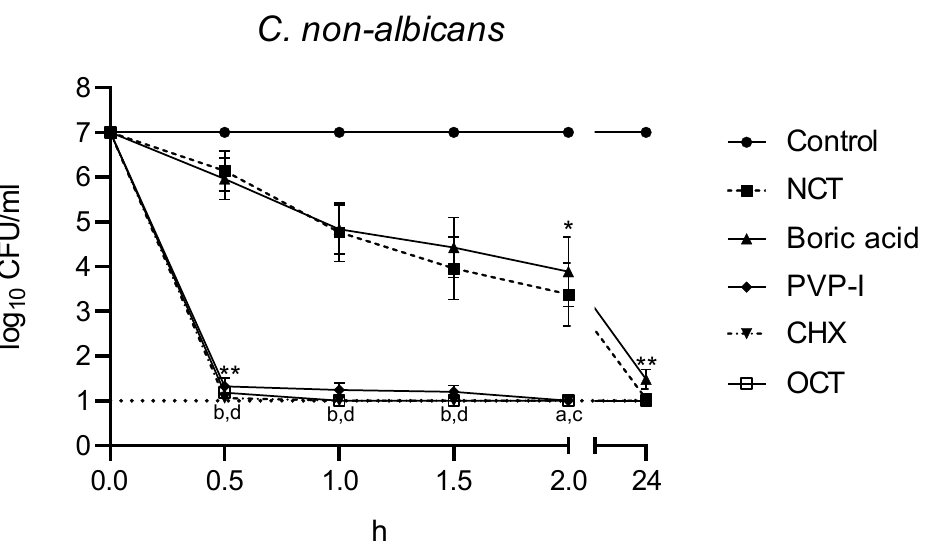
Figure 3. Fungicidal activity of antiseptics against C. albicans (n = 29) at 37 °C and pH 7. Mean values ± standard error of the mean (SEM); * threshold p < 0.05 versus control; ** threshold p < 0.01 versus control; a p < 0.05 versus NCT; b p < 0.01 versus NCT; c p < 0.05 versus boric acid; d p < 0.01 versus boric acid; p > 0.05 between NCT and boric acid; p > 0.05 between PVP-I, CHX, OCT (Kruskal–Wallis test).